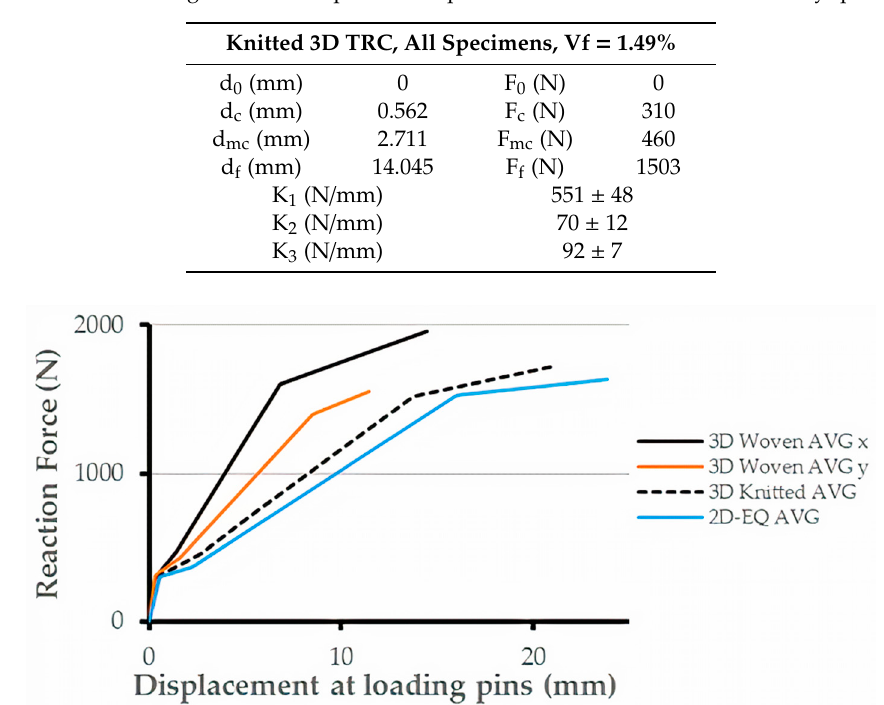
Figure 14. Flexural comparison of averaged curves of all layups. Table 7. Averaged flexural experimental parameters for the equivalent 2D TRC layup. Equivalent 2D TRC, all specimens, Vf = 1.49%